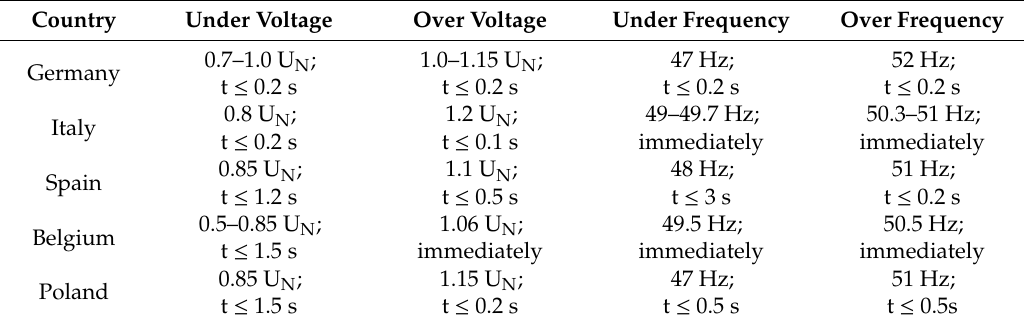
Table 1. Over / under voltage and over / under frequency protection schemes at the connection point of DERs connected to a LV electrical network in selected European